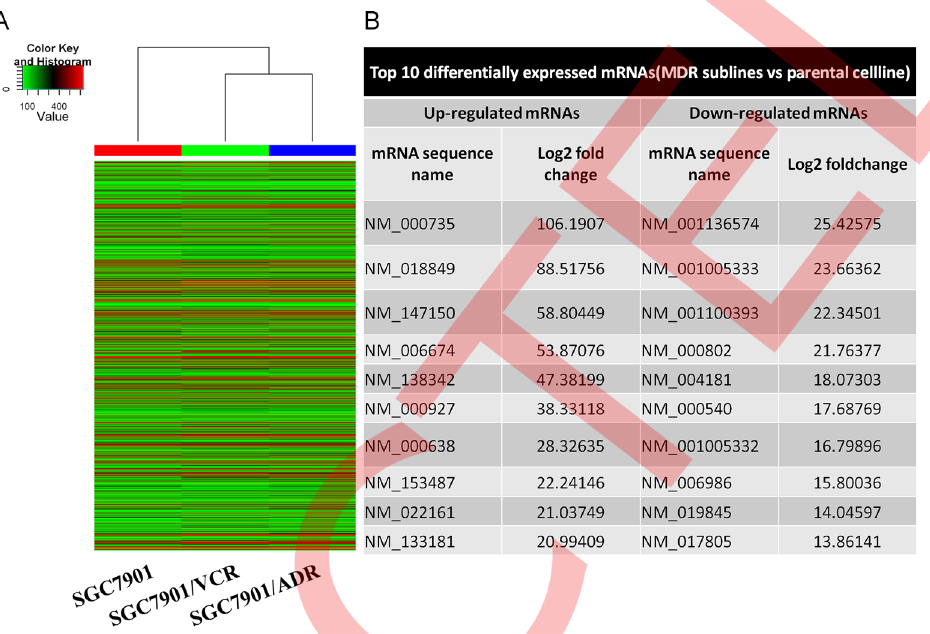
Fig 2. Microarray analysis of MDR-related mRNA of gastric cancer cell lines. A. Heat map and hierarchical clustering dendrogram of mRNA chips. B. Forms showing top 10 differentially expressed